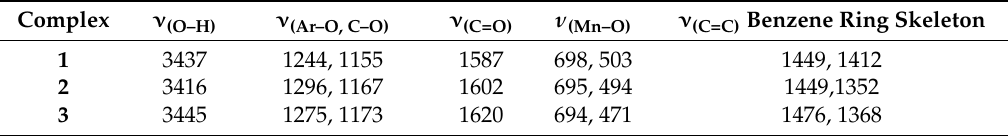
Table 2. Selected FT-IR data for Mn III complexes 1 , 2 , and 3 (cm − 1